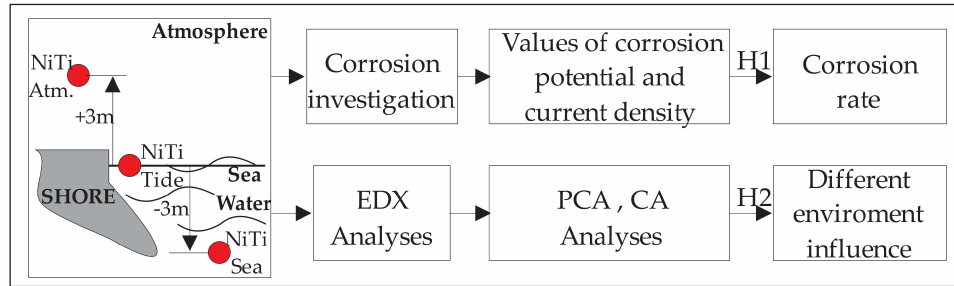
Figure 2. The scheme of the conceptual model of the research for the